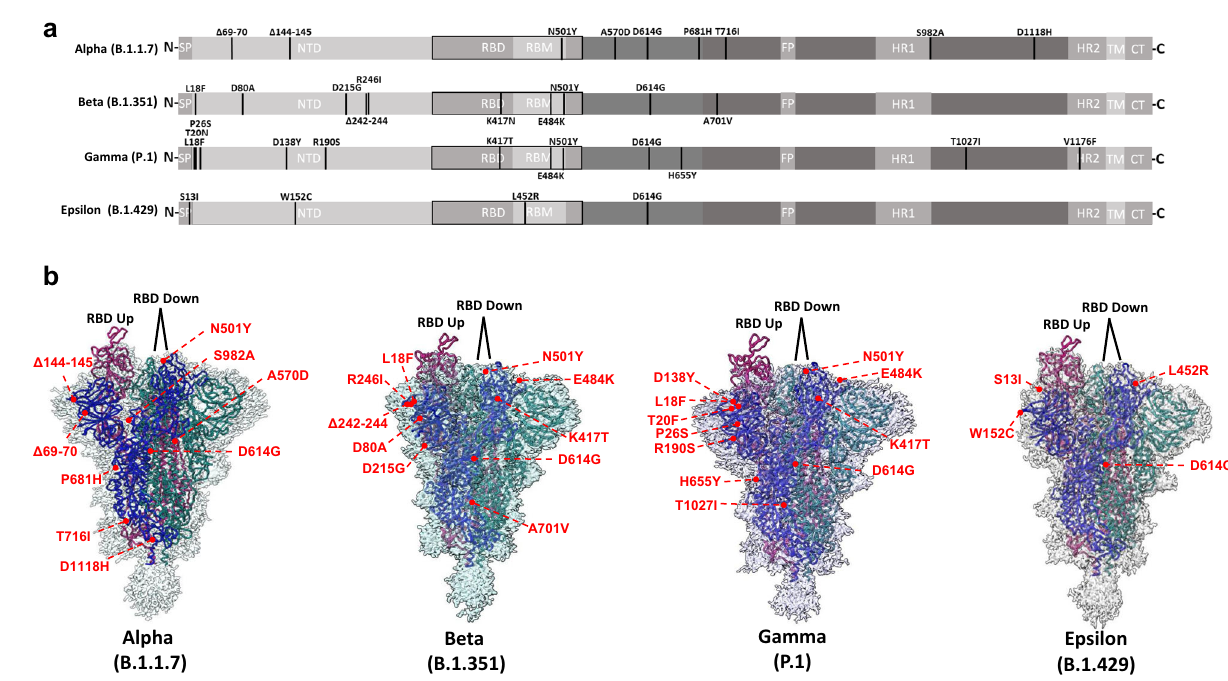
Fig. 3 | Cryo-EM structures of Alpha, Beta, Gamma, and Epsilon spike glyco- proteins. a Linear schematic depicting mutations within variant S proteins (SP signal peptide, NTD N-terminal domain, RBD receptor binding domain, RBM receptorbindingmotif,FPfusionpeptide,HR1Heptadrepeat1,HR2Heptadrepeat